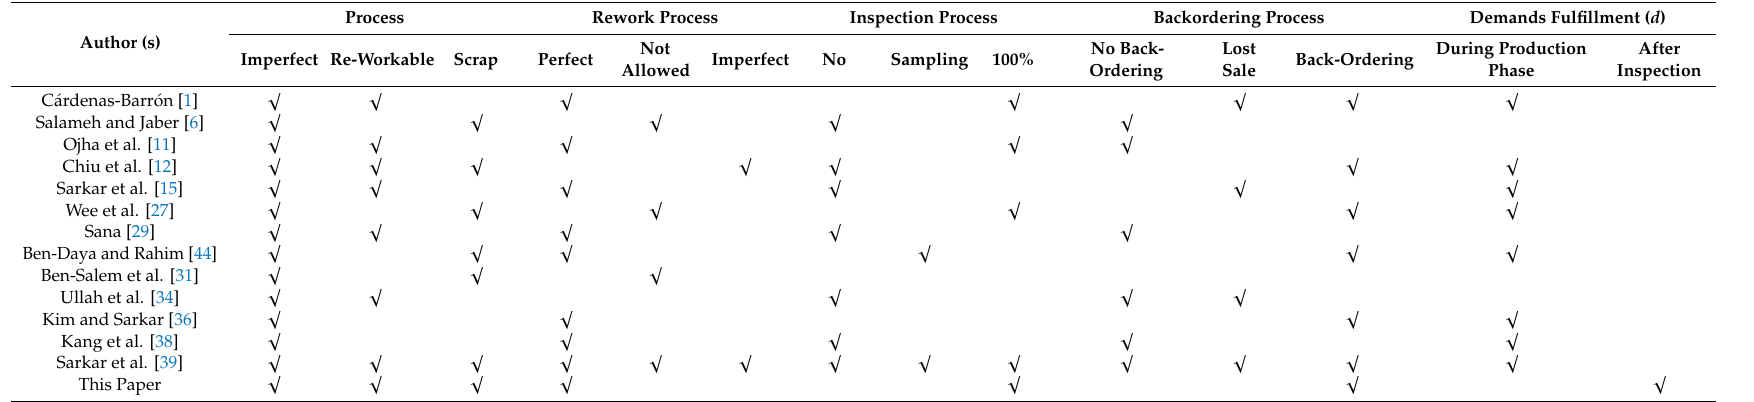
Table 1. Author contribution in the production model on the basis of process, rework, inspection, backordering and